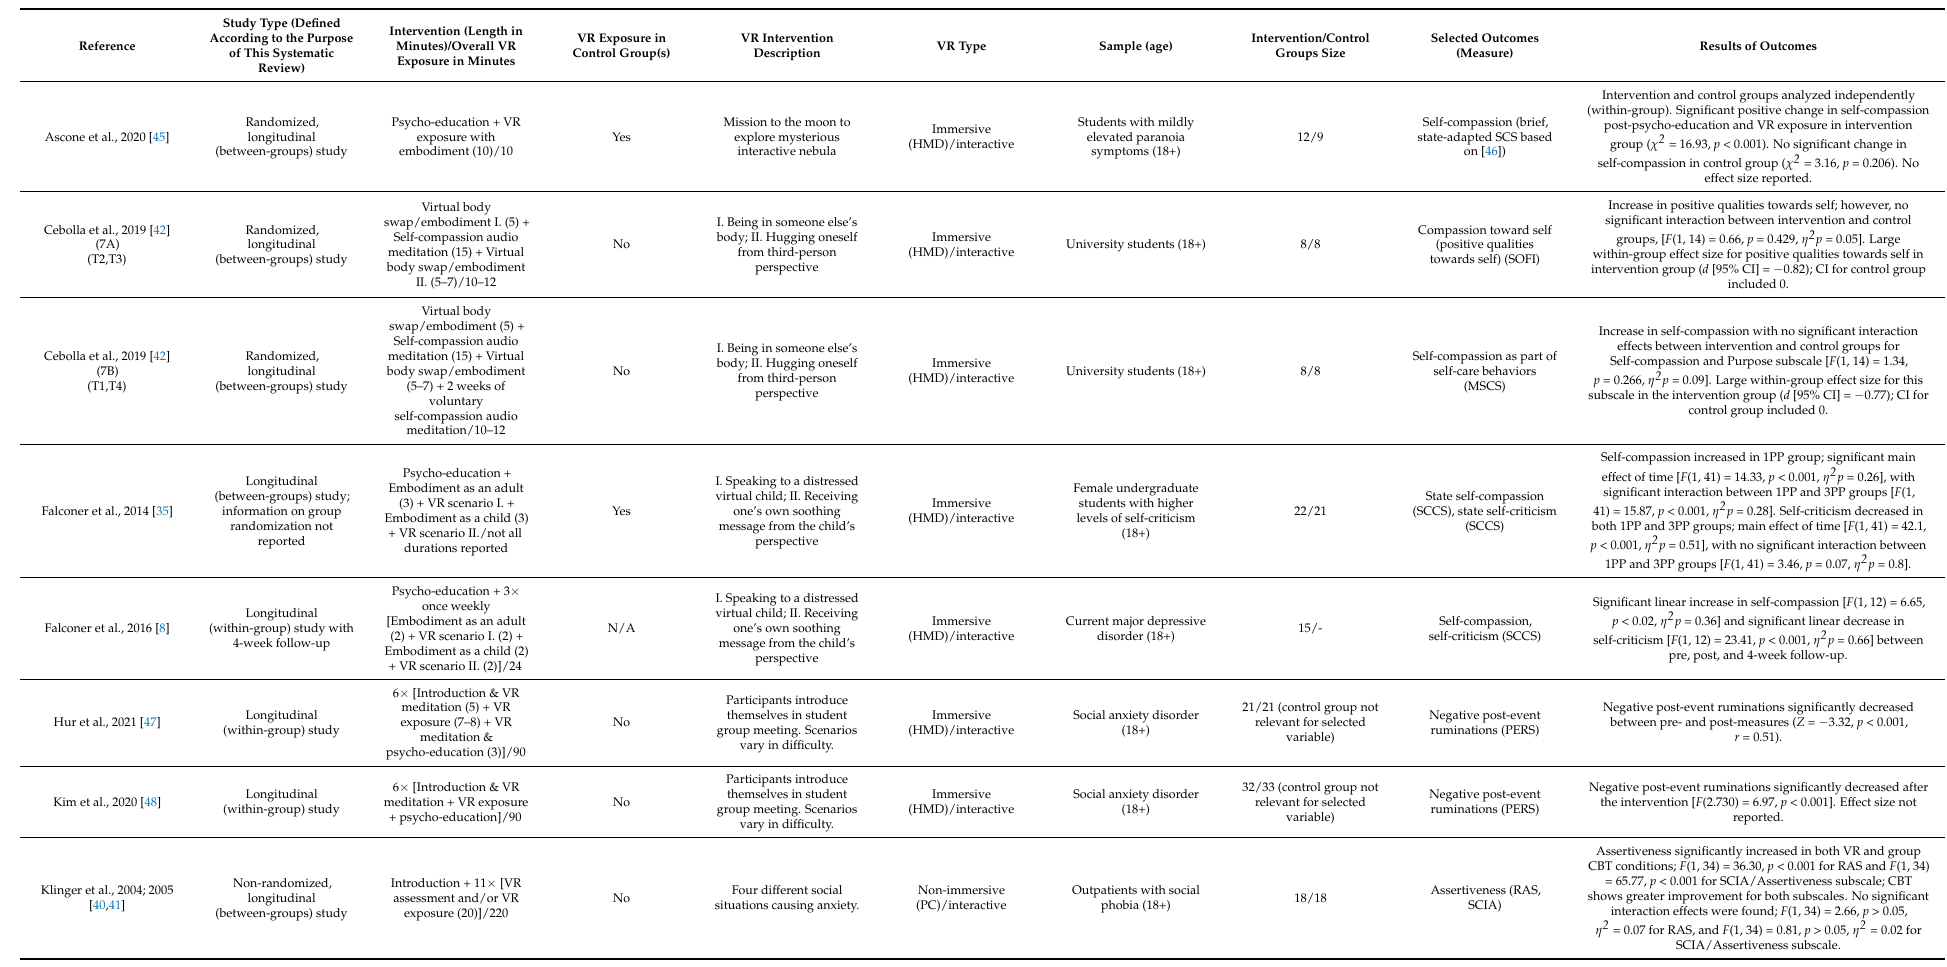
Table 2. Final summary of selected